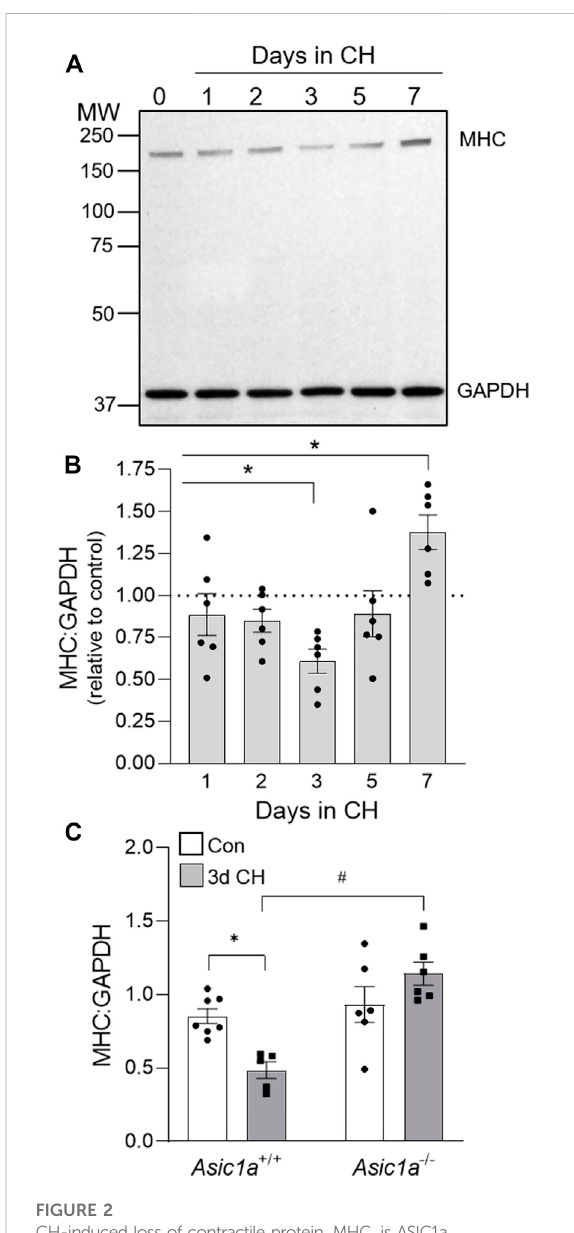
FIGURE 2 CH-induced loss of contractile protein, MHC, is ASIC1a dependent. (A) Representative western blot and (B) the effect of CH exposure (1 – 7 days) on MHC to GAPDH protein expression in whole lunghomogenatesin Asic1a +/+ animals.Thescannedimageofthe fi lm was converted to greyscale and adjusted for brightness/contrast. n = 6/group; analyzed by one-way ANOVA and individual groups compared with Š ídák ’ s multiple comparisons tests. (C) Summary data for MHC to GAPDH in whole lungs from Asic1a +/+ and Asic1a − /- mice under control conditions or following 3-days CH exposure. n =